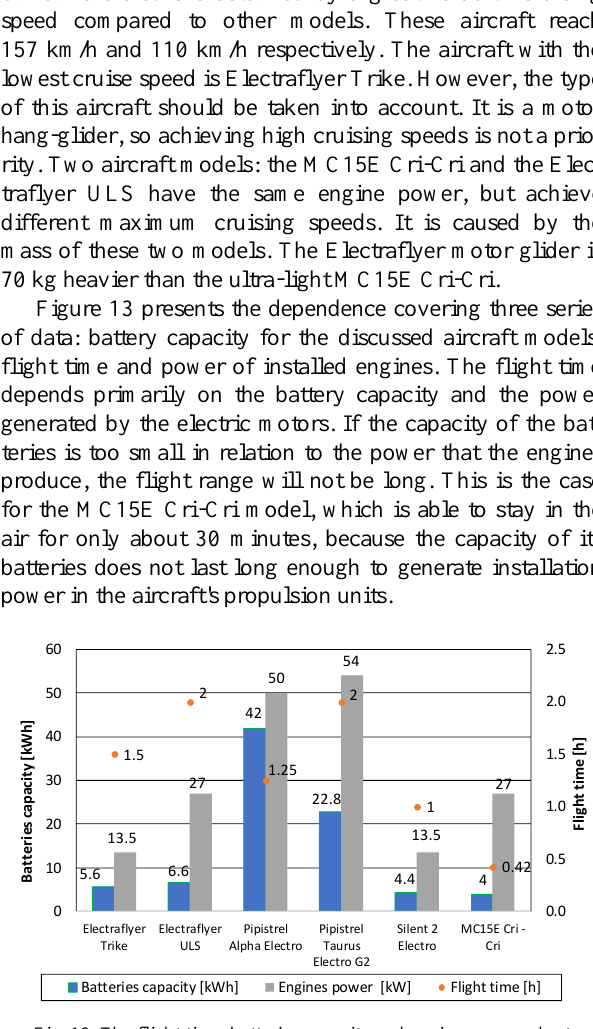
Fig. 13. The flight time, batteries capacity and engines power chart